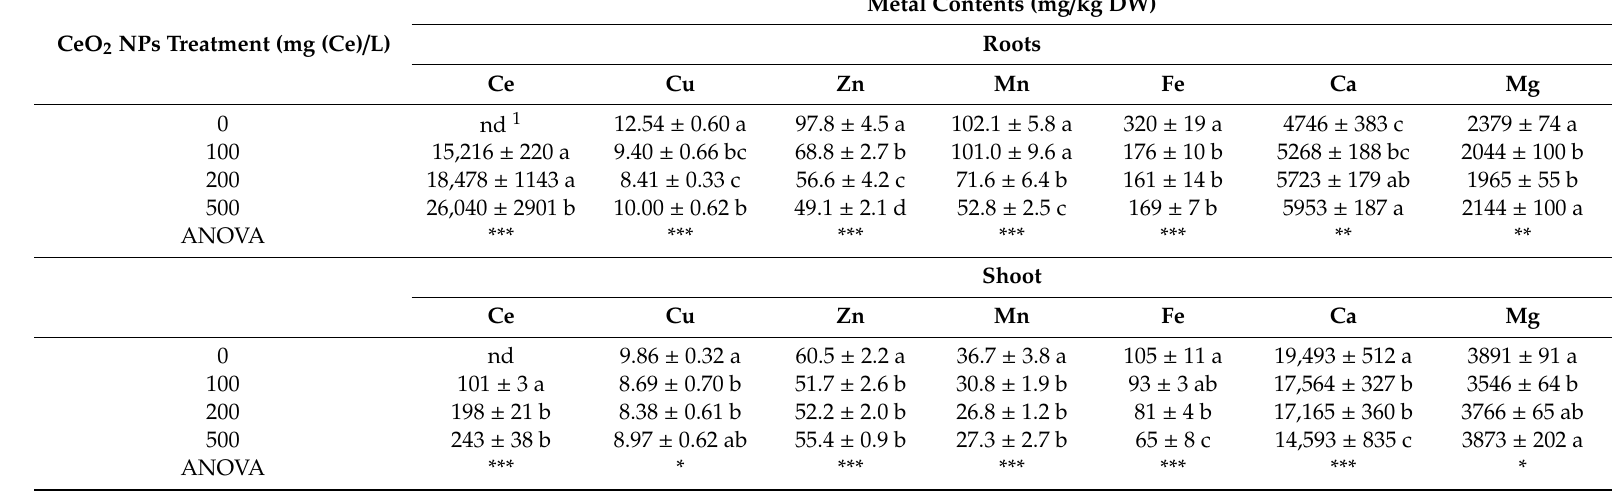
Table 1. Contents of cerium and nutrients in roots and shoots of green pea cultivated in Hoagland solutions supplemented with nanoparticulate CeO 2 . Data are means ± SD ( n = 6). One-way ANOVA was used to evaluate treatment e ff ects. Statistically significant di ff erences at α = 0.001 are indicated with ***, those at α = 0.01 are shown with **, while those at α = 0.05 are indicated with *. Letters a, b, c, and d indicate statistical di ff erences among treatments as evaluated by the Tukey’s post hoc test ( α =